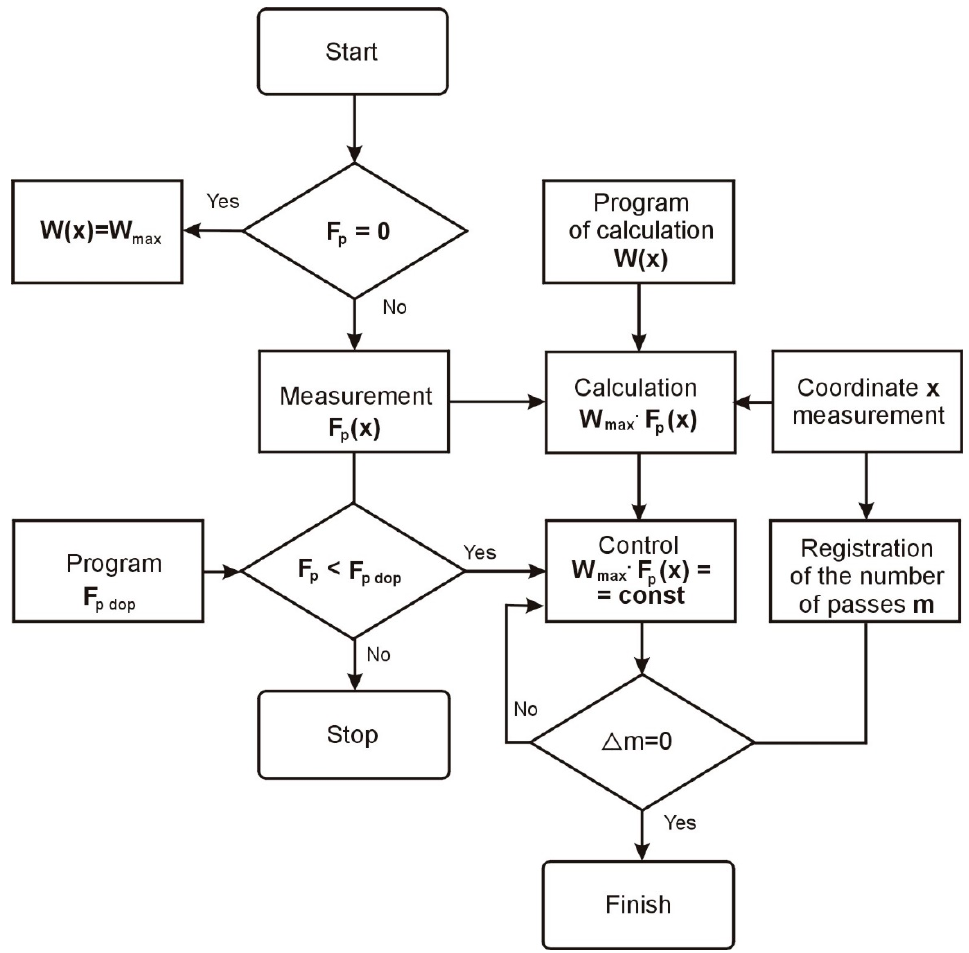
Materials 2022 , 15 , 5265 Figure 4. Block diagram of the adaptive control algorithm of the grinding process.